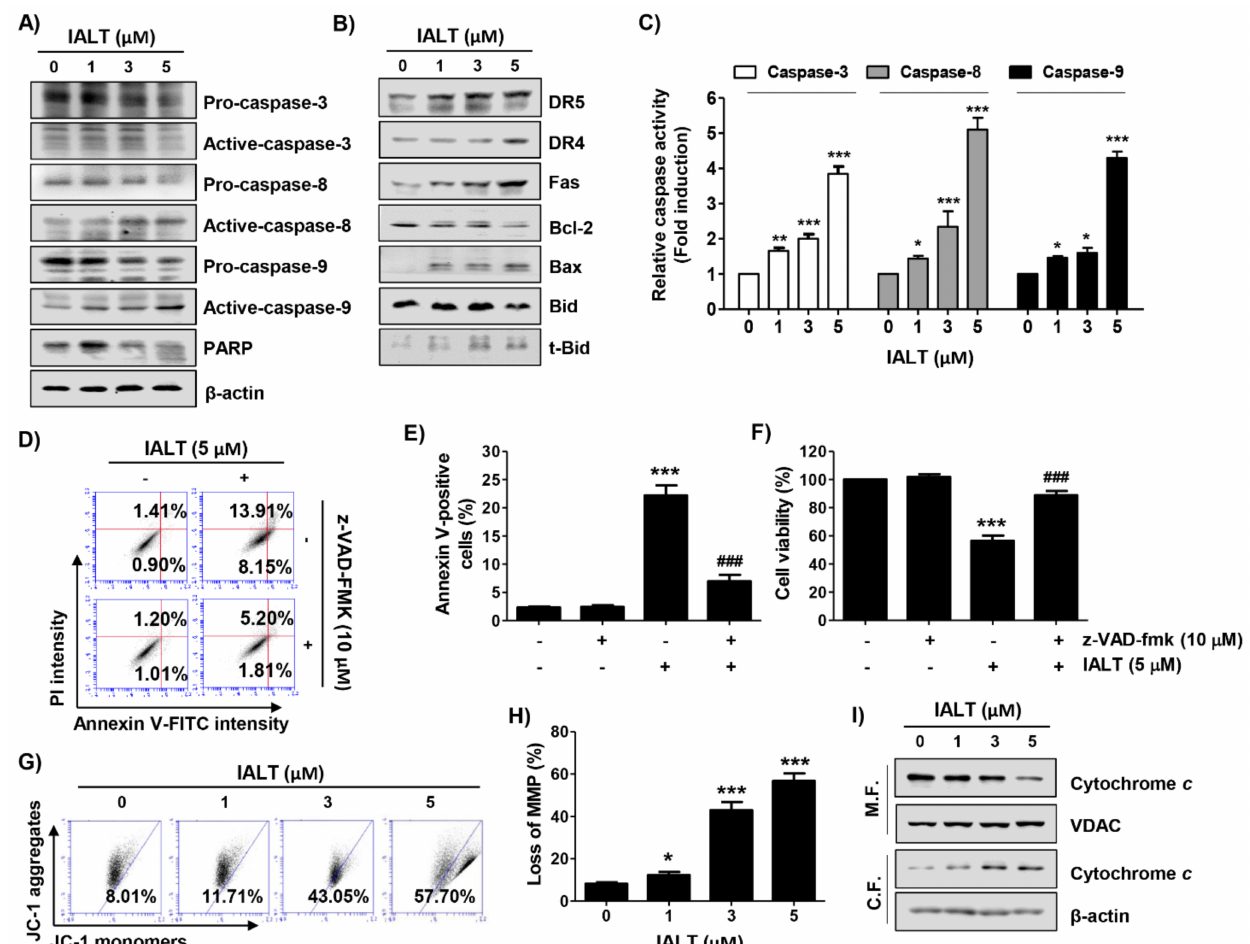
Figure 2. Activation of caspases, regulation of expression of Bcl-2 family proteins, loss of mitochondrial membrane potential (MMP), and cytosolic release of cytochrome c by IALT in Hep3B cells. Cells were treated with the indicated concentrations of IALT for 48 h ( A – C , G – I ) or treated with 10 µ M N-benzyloxycarbonyl-Val-Ala-Asp-fluoromethylketone (z-VAD-fmk) for 1 h, and then treated with 5 µ M IALT for another 48 h ( D – F ). ( A , B ) The results of Western blot analysis of the indicated proteins are presented. The immunoblot for β -actin served as a loading control. ( C ) Caspase activities in each sample were measured using colorimetric enzyme-linked immunosorbent assay (ELISA) assay kits. ( D , E ) Quantitative analysis of apoptosis induction by annexin V and PI staining was performed. ( D ) Representative profiles of flow cytometry results are presented. ( E ) The percentage of apoptotic cells was expressed as a percentage of the total number of annexin V-positive cells. ( F ) Cell viability was measured by the MTT assay. ( G , H ) Cells were stained with 5,5 (cid:48) ,6,6 (cid:48) -Tetrachloro-1,1 (cid:48) ,3,3 (cid:48) -tetraethyl- imidacarbocyanine iodide (JC-1) dye and then analyzed by flow cytometry for the extent of MMP loss. ( G ) Representative profiles of flow cytometry results. ( H ) The results of quantitative analysis of MMP loss are presented. ( I ) Mitochondrial and cytosolic proteins were isolated from cells, and cytochrome c expression was analyzed by Western blot analysis. Protein loading was confirmed by the analysis of voltage-dependent anion channel (VDAC) and β -actin expression in each protein extract. M.F., mitochondrial fraction; C.F., cytosolic fraction. ( C , E , F , H ) Data are expressed as the mean ± SD (* p < 0.05, ** p < 0.01 and *** p < 0.001 compared to untreated cells. ### p < 0.001 compared to 5 µ M IALT-treated